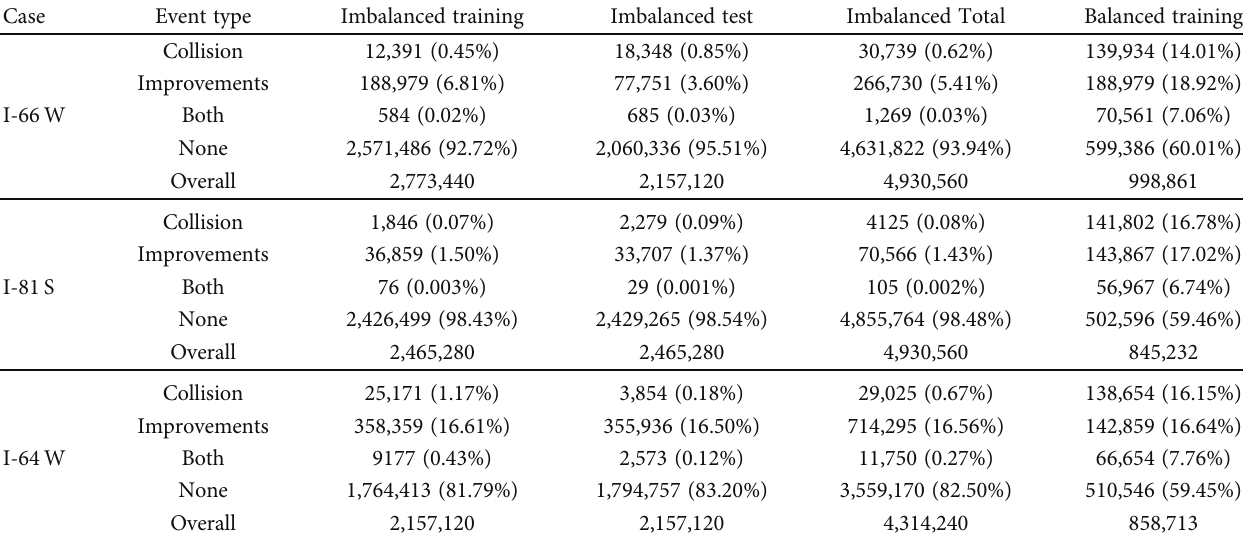
Table 5: Number of disruptions by type for case study